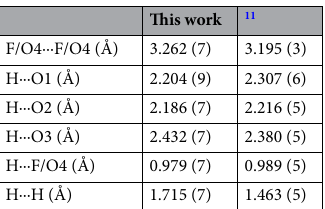
Table 4. The refined neutron bond distances between the proton site and the surrounding anions. The corresponding values refined by 11 are reported for comparison.